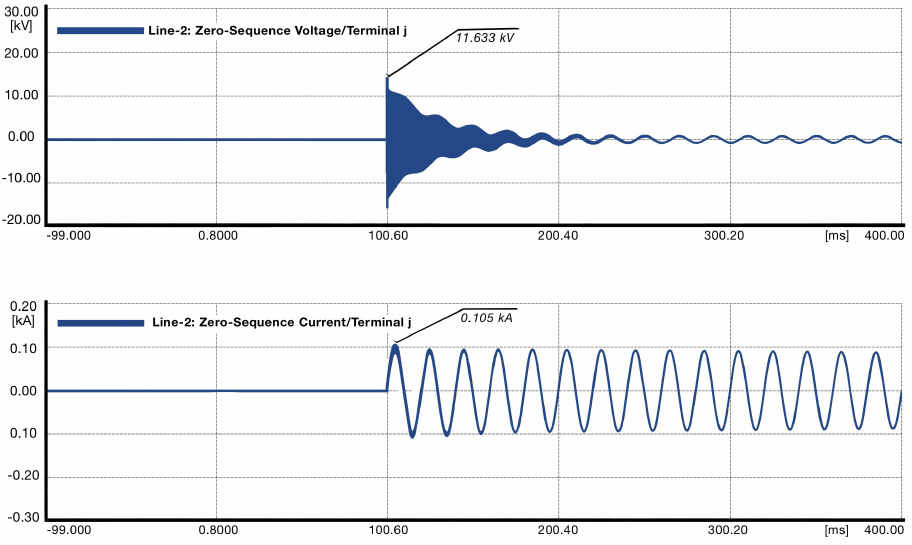
Figure 10. Zero-sequence voltage and current for a three-phase